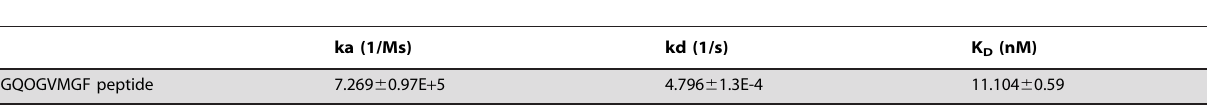
Table 4. Surface plasmon resonance analysis of Simplagrin-RGQOGVMGF